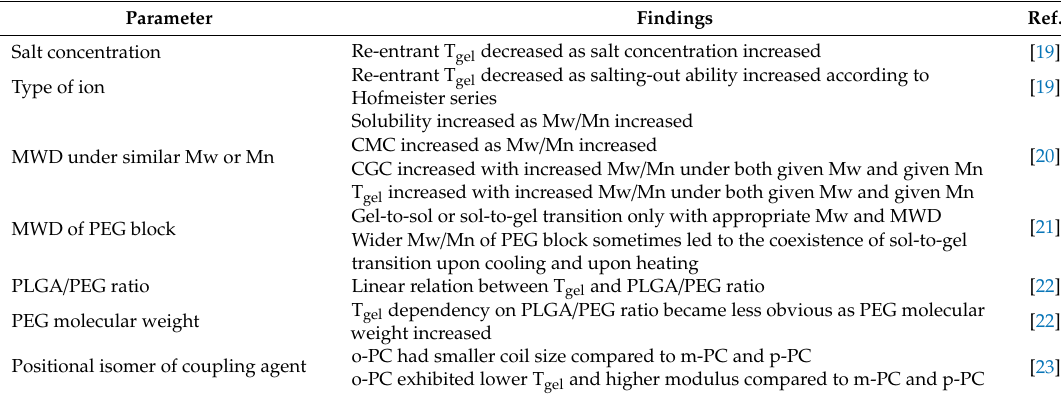
Table 1. Parameters a ff ecting thermoresponsive